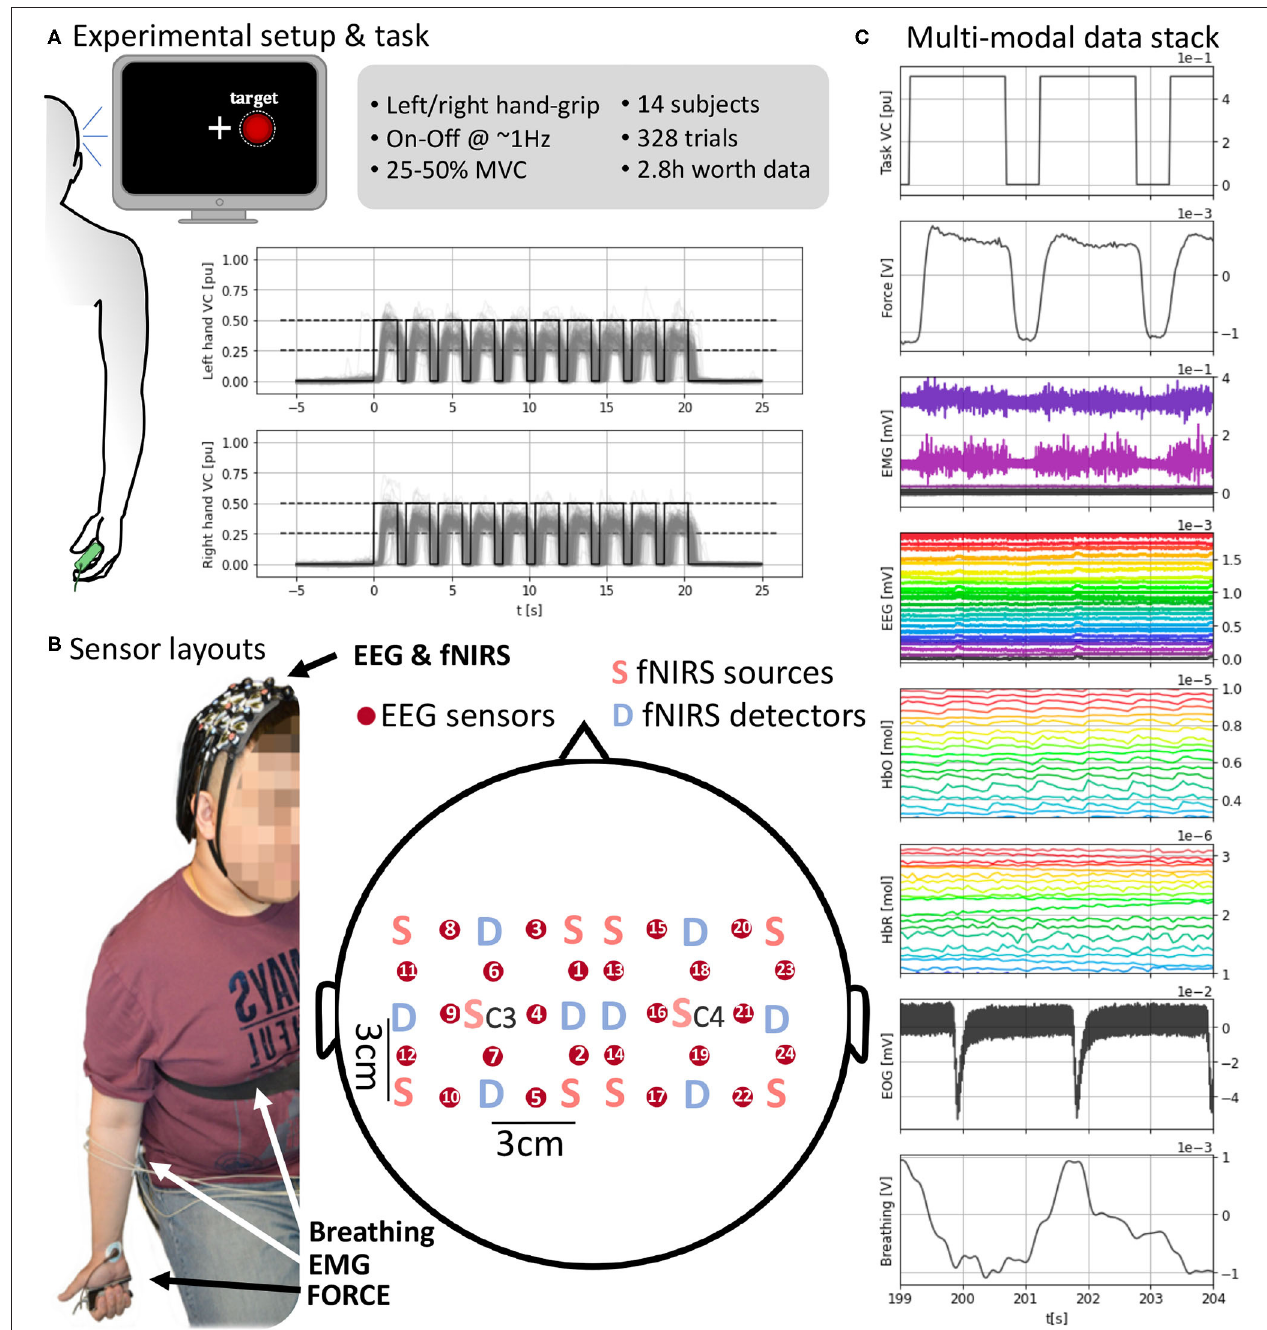
FIGURE 1 | (A) (Left) Experimental setup with visual feedback. (Top right) Task and data set details. (Bottom right) Task execution across subjects time-locked to the “Go” cue at t = 0 s. (B) Sensor layout and EEG and fNIRS sensor arrangement. fNIRS light sources and detectors are placed in a 5 × 5 symmetrical grid leaving a required 3 cm distance. EEG electrodes, red circles, are placed between each pair of sources and detectors overlaying the fNIRS sensing area so fNIRS and EEG measures are co-located. Each grid is centered around C3 and C4 for the respective hemisphere. (C) A subject’s full stack of neurobehavioral data (5 s, selected channels per modality for readability). (Top-bottom) Force target for the right hand; force produced by subject’s right hand; EMG channels from right forearm; EEG channels; HbO (oxyhemoglobin); HbR (deoxygenated hemoglobin); EOG with two eye blinks; breathing from chest strap stretch sensor. Units in the bottom x-axis and each corresponding